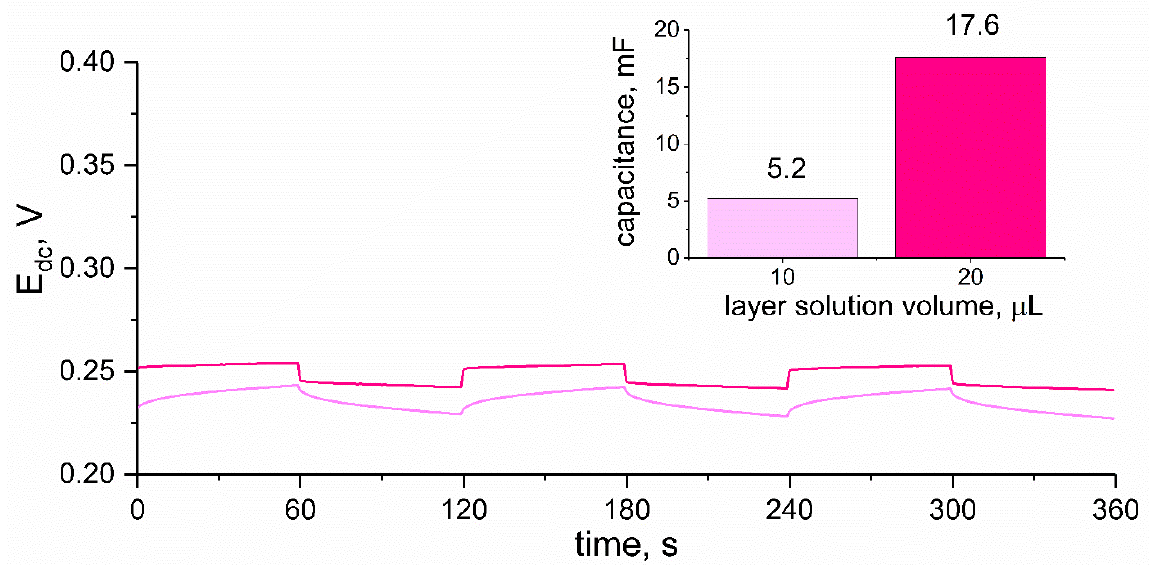
Figure 3. Chronopotentiograms recorded for RuO 2 -PEDOT:PSS material dispersed in tetrahydrofuran (THF). Light color corresponds to the lower thickness of the solid-contact layer (10 µ L) and dark color indicates greater thickness (20 µ L). Inset: electrical capacitance values compared for studied thicknesses of solid-contact layer.